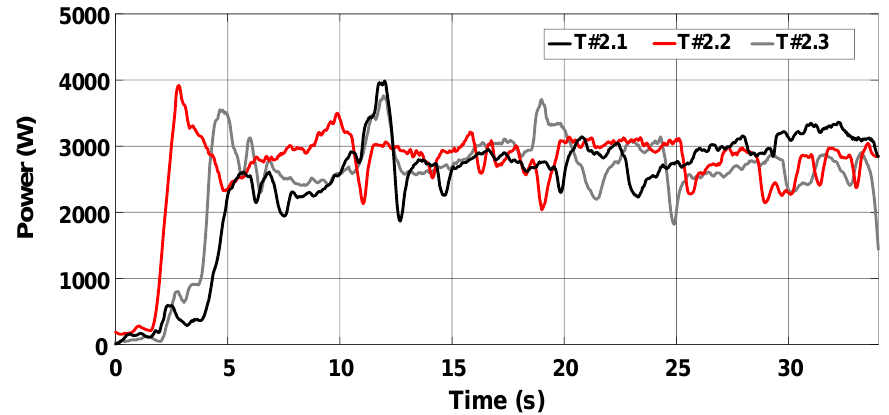
Figure 22. Velocity of the electric tractor during the trial sessions carried out on firm soil with the slip manually controlled by the operator.